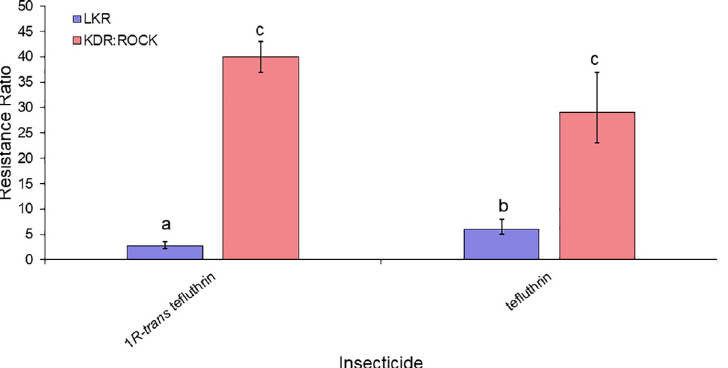
Fig 7. Levels of resistance levels conferred to tefluthrin and 1 R-trans tefluthrin in the LKR and KDR:ROCK strains having the 410L+1016I+1534C and 989P+1016G alleles, respectively. The RR for KDR:ROCK to tefluthrin was previously published [25] and is given here for comparison purposes. Bars with different letters are significantly different based on non-overlap of the 95% confidence